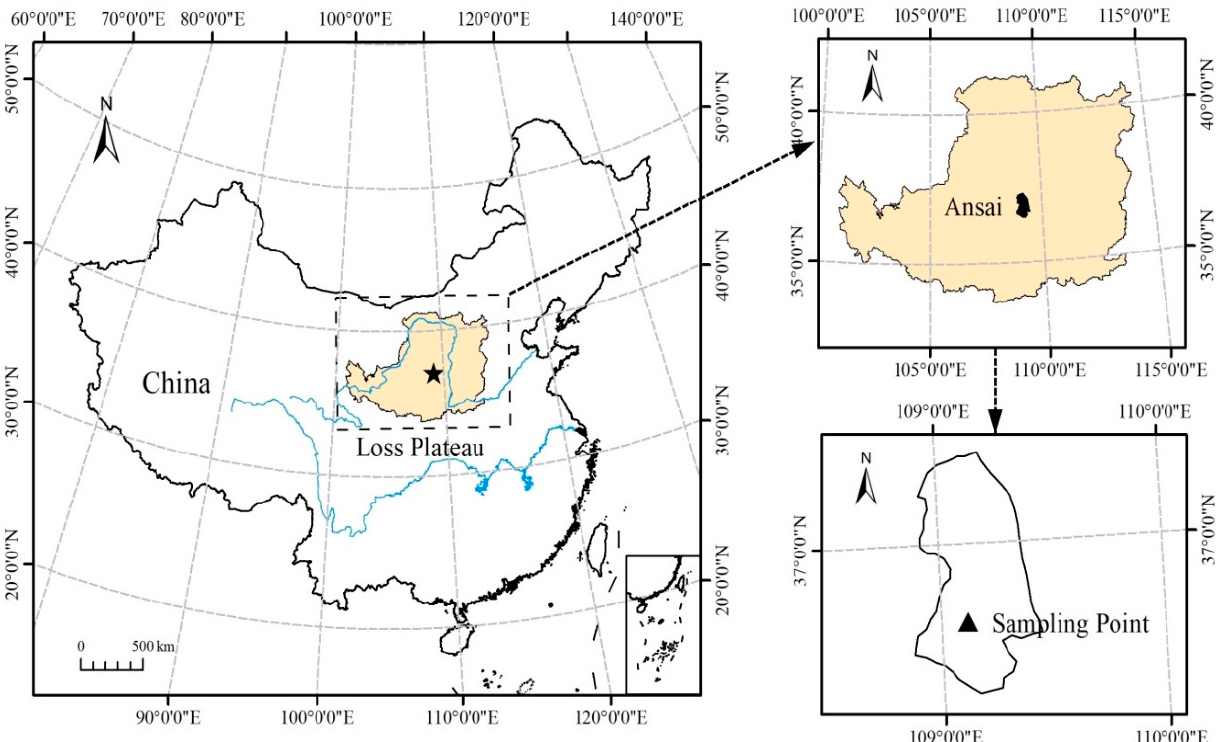
Figure 1. The location at the Zhifanggou station on the Loess Hilly Region.